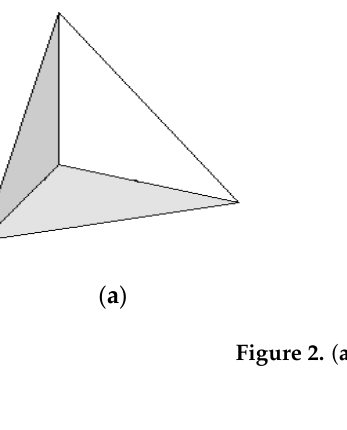
( c ) Figure 3. ( a ) Dihedral, ( b ) co-pol and ( c ) cross-pol polarimetric signatures characterizing scattering. ( a ) ( b ) ( c ) Figure 4. ( a ) Left helix, ( b ) co-pol and ( c ) cross-pol polarimetric signatures characterizing scattering. ( a ) ( b ) ( c ) Figure 5. ( a ) Cloud of randomly oriented dipoles, ( b ) co-pol and ( c ) cross-pol polarimetric signatures characterizing scat- tering.